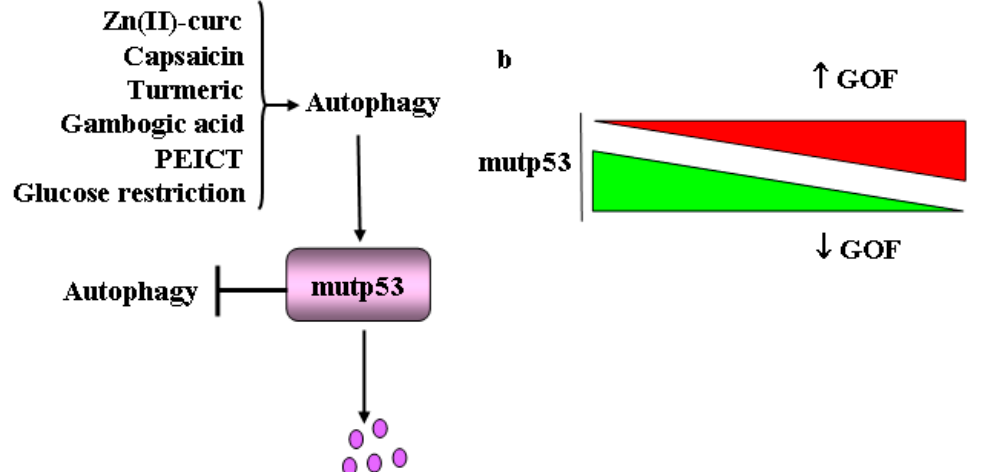
Figure 4. Interplay between mutp53 and autophagy and the effect of mutp53